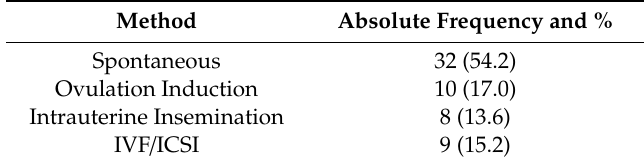
Table 4. Methods used to achieve pregnancy in 59 Mexican Müllerian anomaly